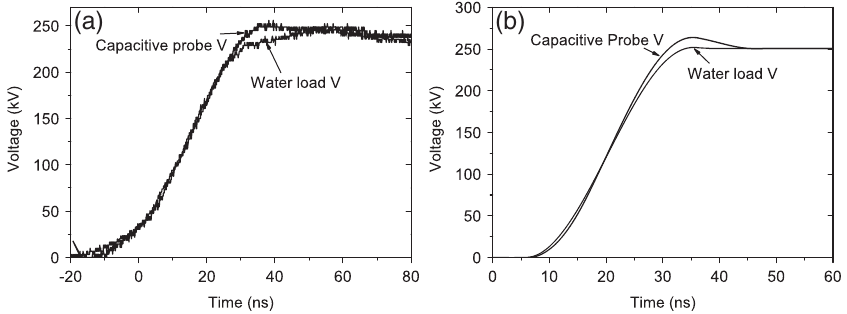
FIG. 14. Calibration result for the capacitive probe: (a) measured result and (b) simulation result with MAGIC